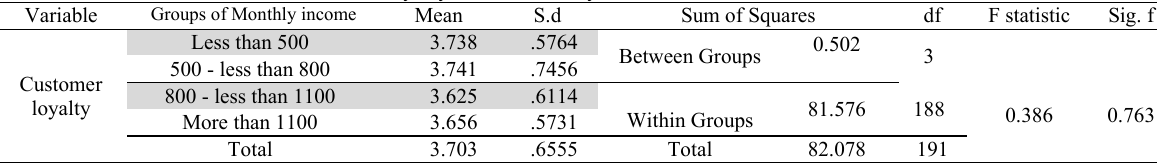
ANOVA test for differences in customer loyalty due to monthly